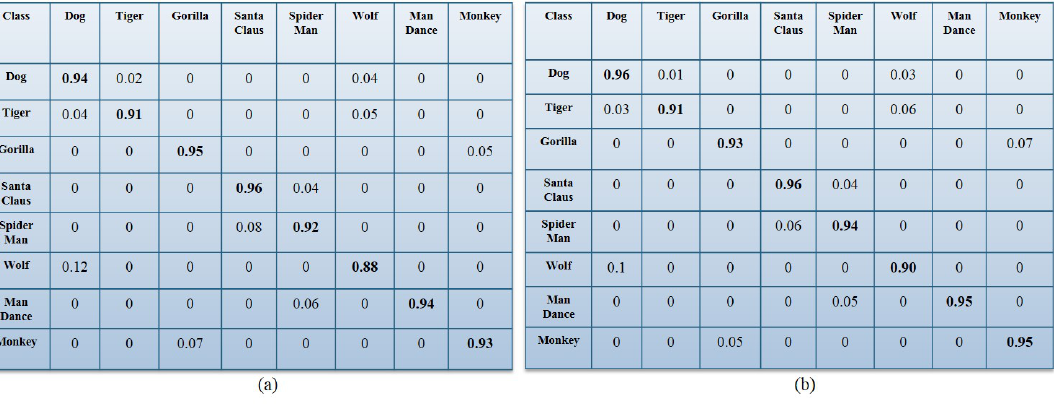
Figure 12. ( a ) Confusion Matrix for proposed method on AVD8 dataset for image query and ( b ) Confusion Matrix for proposed method on AVD8 dataset for video query.